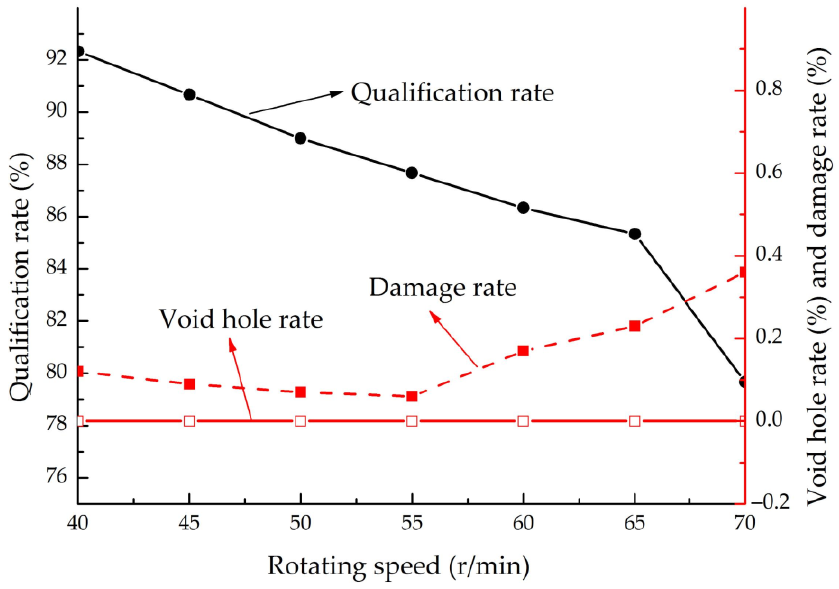
Figure 15. Trend chart of bench test results.